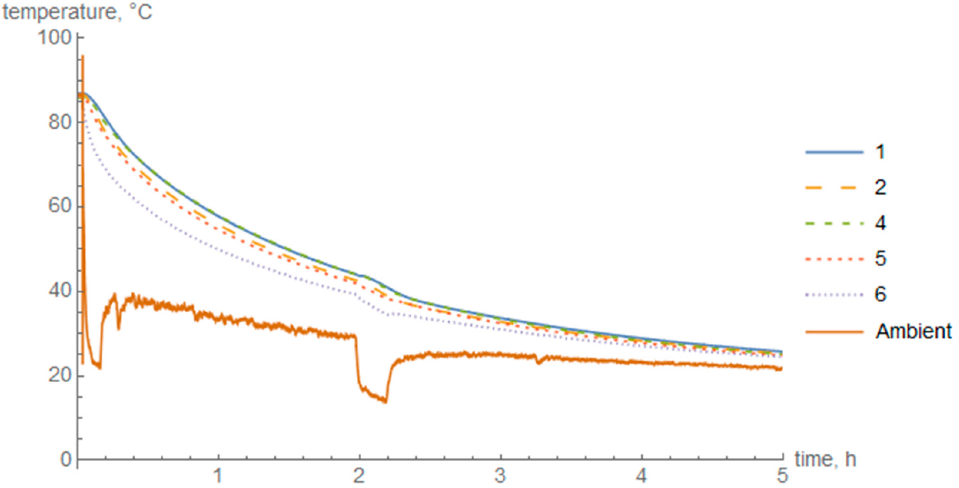
Figure 9. Temperature change in individual layers during air cooling.